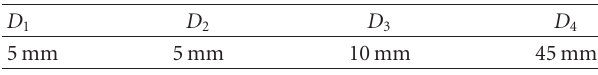
Table 1: The distance between the successive slots in the arms of the high-band antenna. D 1 D 2 D 3 D 4 5mm 5mm 10 mm 45mm